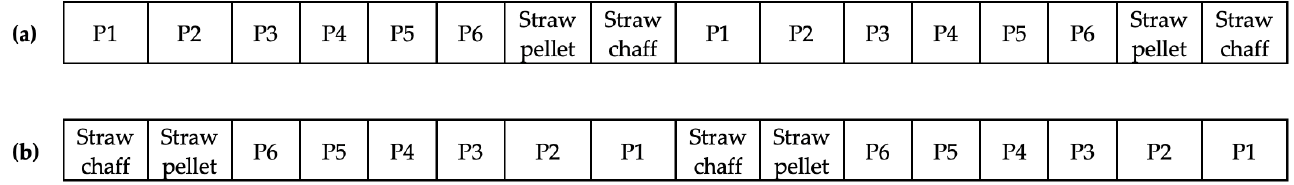
Figure 1. Experimental setting — allocation of bedding materials to compartments with animals: ( a ) 1st experimental cycle; ( b ) 2nd experimental cycle. ( a ) 1st experimental cycle; ( b ) 2nd experimental